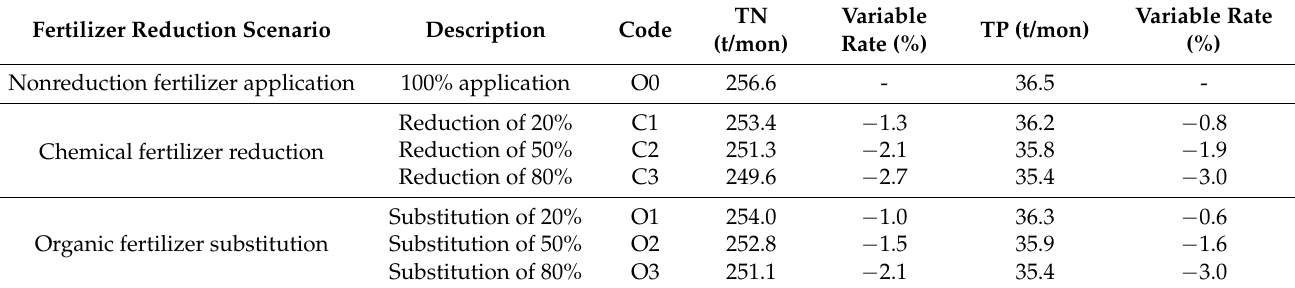
Table 2. Simulation results of TN, TP, and the variable rate under three types of fertilizer reduc- tion